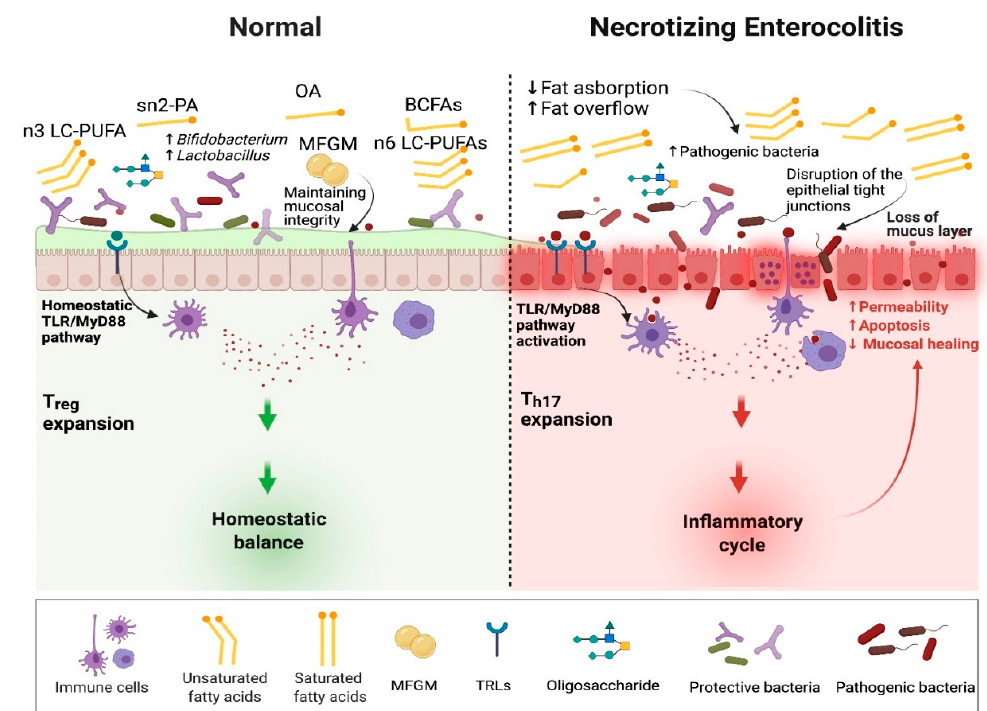
Figure 2. The role of dietary fatty acids in the pathogenesis of necrotizing enterocolitis. Sn2-PA, sn2 palmitic acid; OA, oleic acid; MFGM, milk fat membrane; BCFAs, branched-chain fatty acids; LC-PUFAs, long chain polyunsaturated fatty acids; TLR/MyD88, toll-like receptor/myeloid differentiation primary response gene 88; T reg , regulatory T cells; T h17 , T helper 17 cells.